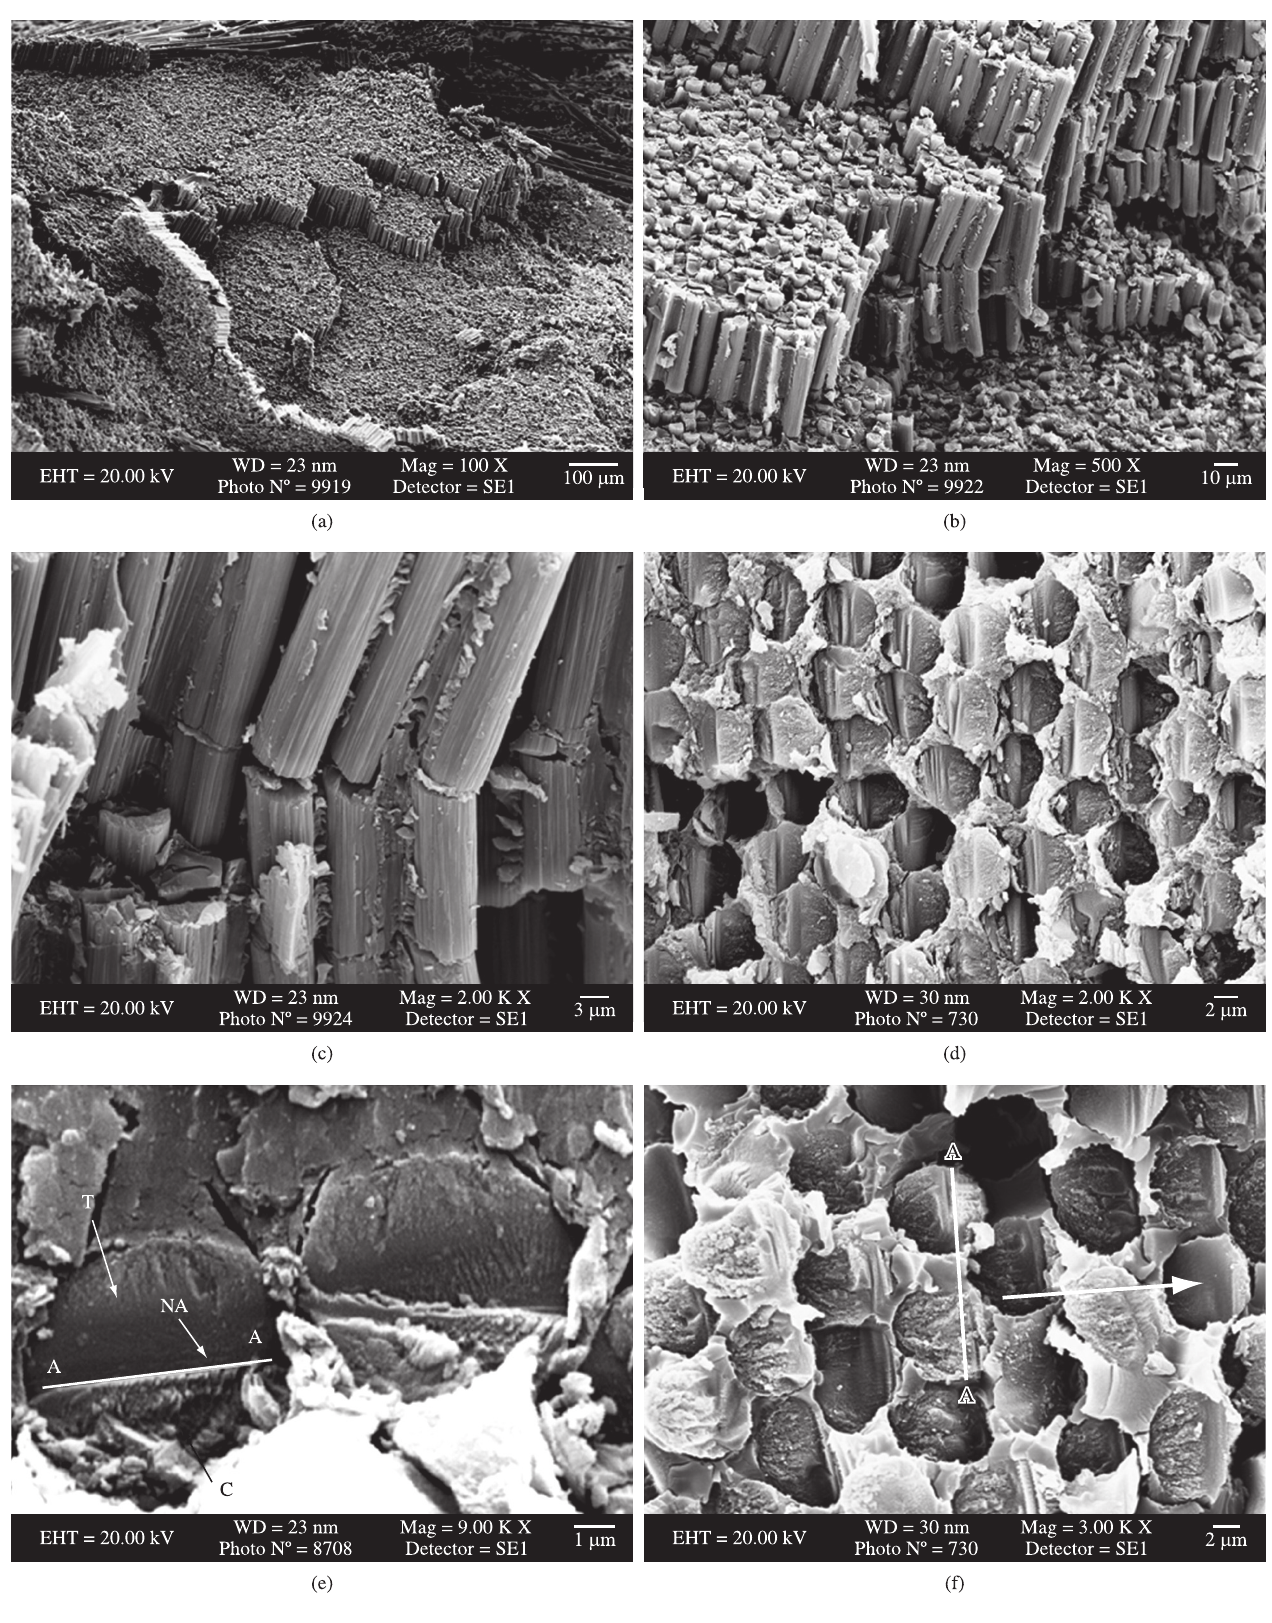
Figure 8. a) Stepped fiber fracture; b) Fiber fracture by micro buckling and fracture at different heights; c) Microbuckling/Kinking; d) Chop marks typical of failure under compressive load; e) High magnification fractograph showing chop marks separating tension and compression by neutral axis; and f) Local crack propagation direction indicated by an arrow perpendicular to neutral axis